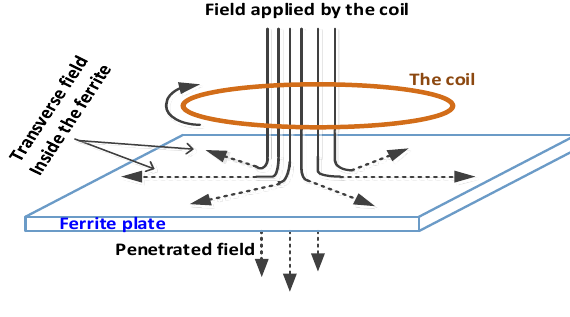
Figure 1. Passive shielding using ferrite [14].